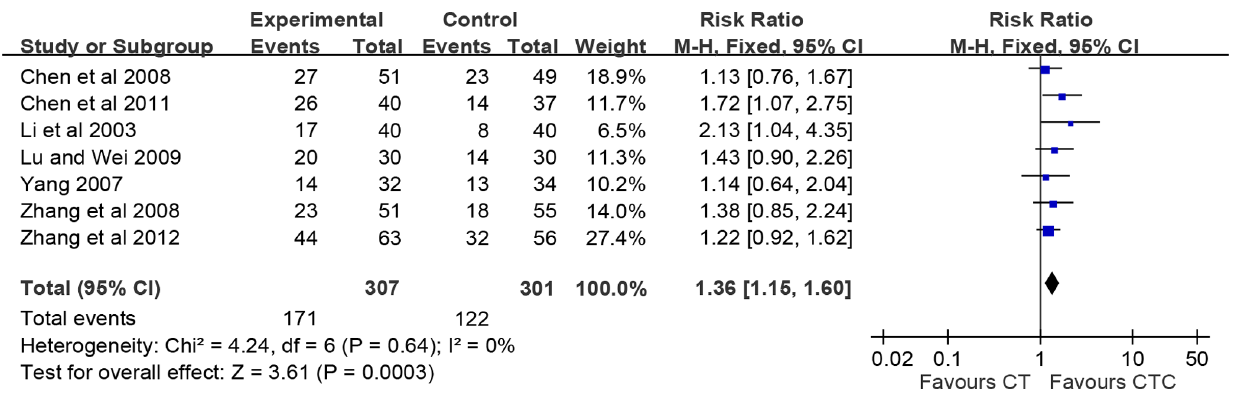
PLOS ONE | www.plosone.org 2 February 2013 | Volume 8 | Issue 2 |